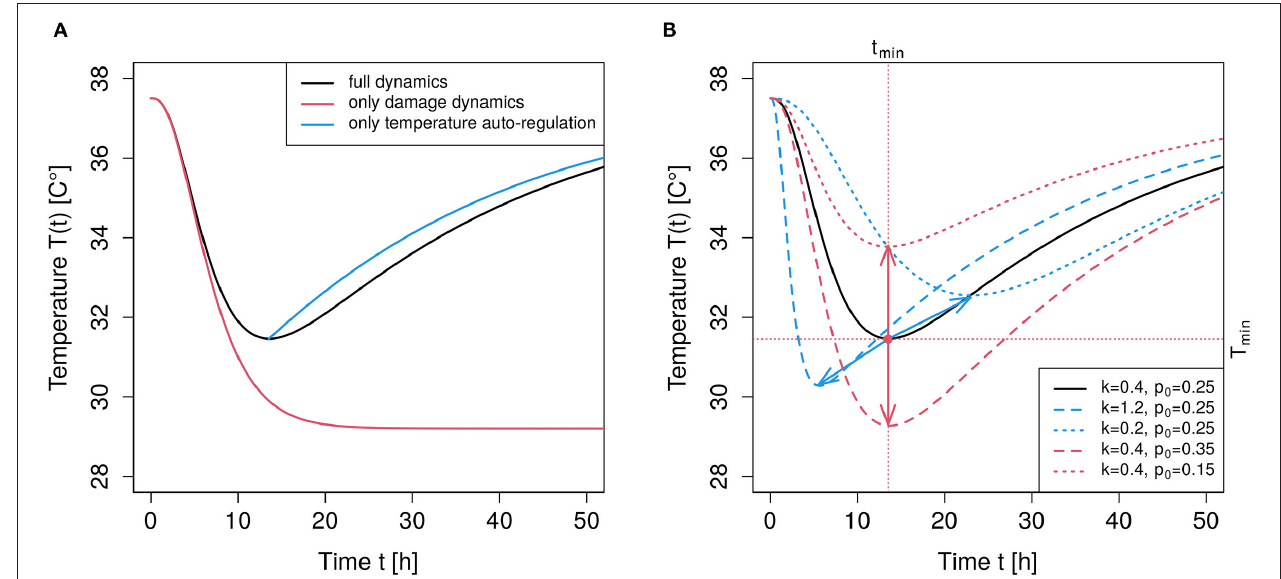
FIGURE 1 | Illustration of parameter impact. (A) The black curve shows the time course of the full dynamics given by Equation (5) with s = 3, T n = 37.5 ◦ C , r = 0.04 1 , k = 0.4 1 , p 0 = 0.25, T ( t = 0) = T n . The red curve results from the damage part alone, i.e., r = 0.0 and all other parameters as for the full dynamics. The h h blue curve results from setting p 0 = 0 when the point of minimum temperature is reached in the full dynamics model, and shows the effect of temperature regulation alone. (B) Black curve as in the left panel (full dynamics). The red curves result upon changing the value of p 0 , i.e., a larger p 0 = 0.35 yields the dashed red curve, a smaller p 0 = 0.15 yields the dotted red curve, thus, changing p 0 leads to a vertical shift of the temperature minimum (see red arrows). The blue curves result upon changing the value of k , i.e., a larger k = 1.2 1 gives the dashed blue curve and a smaller k = 0.2 1 leads to the dotted blue curve. Increasing the value of k lowers the h h minimum and shifts the minimum to an earlier time (see blue